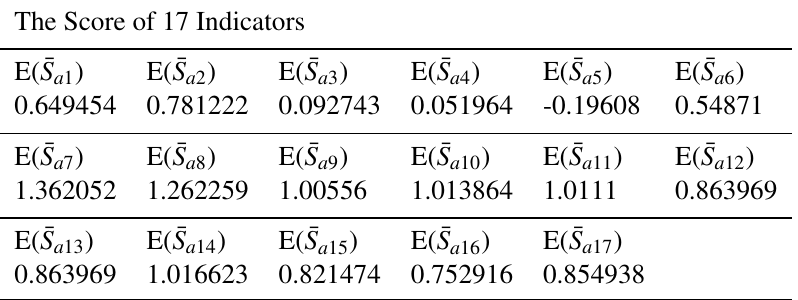
Table 4 Scores of indicators in the cross-cultural competence evaluation model.